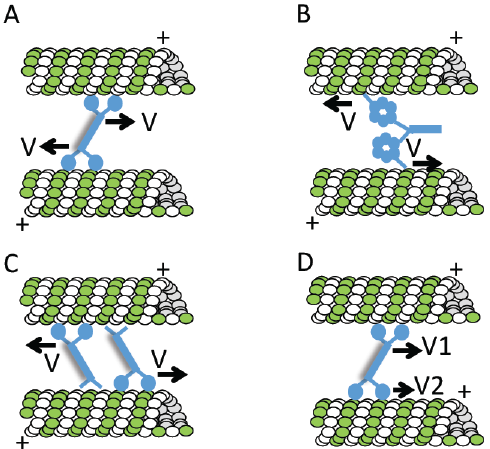
Figure 5. Schematics for how different motor proteins can crosslink and slide two microtubules apart. ( A ) A kinesin-5 homotetramer can walk towards the plus-end of each filament it crosslinks; ( B ) Kinesin-14 dimers crosslink microtubules via motor (circles) and non-motor (lines) domains. The motor domains can bind either filament and walk towards its minus-end; ( C ) Dynein dimers can walk towards the minus-ends of the microtubules. Each motor domain in the dimer may interact with a different filament; ( D ) Kinesin-12 homotetramers may slide parallel microtubules relative to each other by walking faster on one filament in the pair. Tubulin dimer: green, white; motor proteins: blue; V = velocity; in D, V1 is greater than V2; plus-end of the microtubule is also indicated (+).